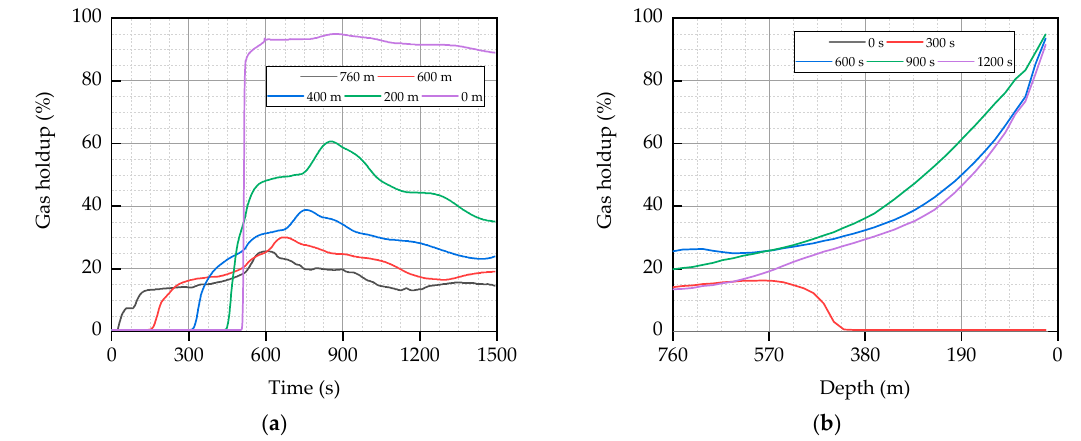
Figure 14. Variation of gas holdup at different: ( a ) times; and ( b ) depths.